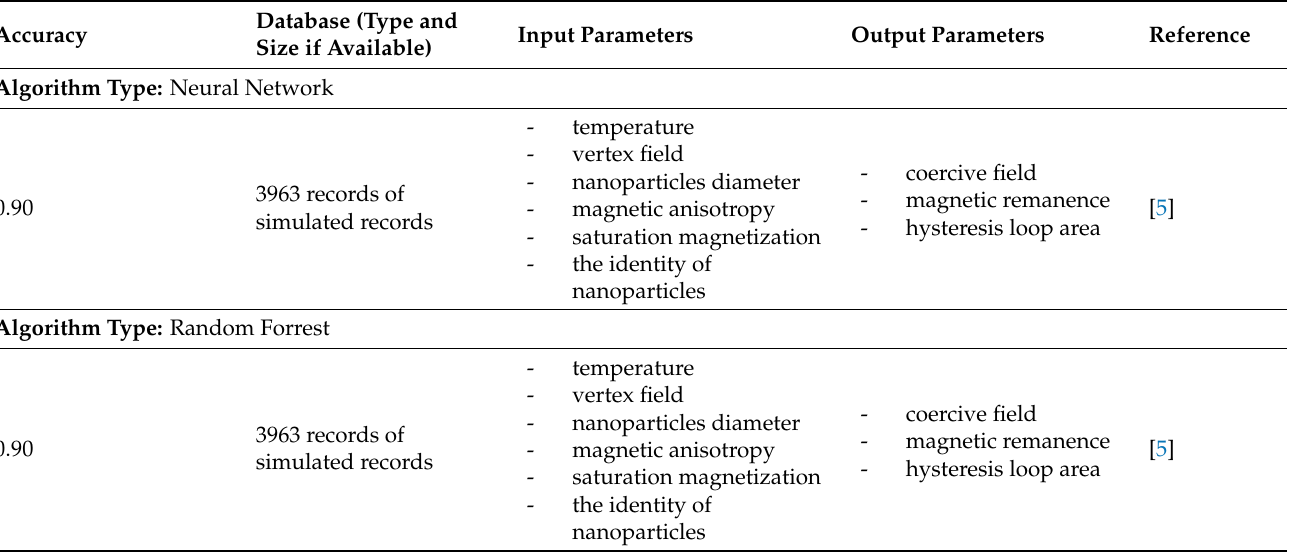
Table 5. The comparison of the algorithm’s performance takes into account the prediction of power losses of magnetic